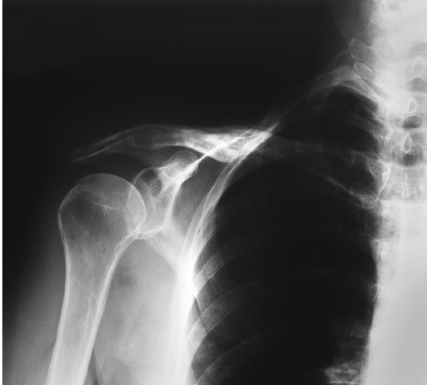
Figure 3: Radiograph of the healed right clavicle fracture after hardware